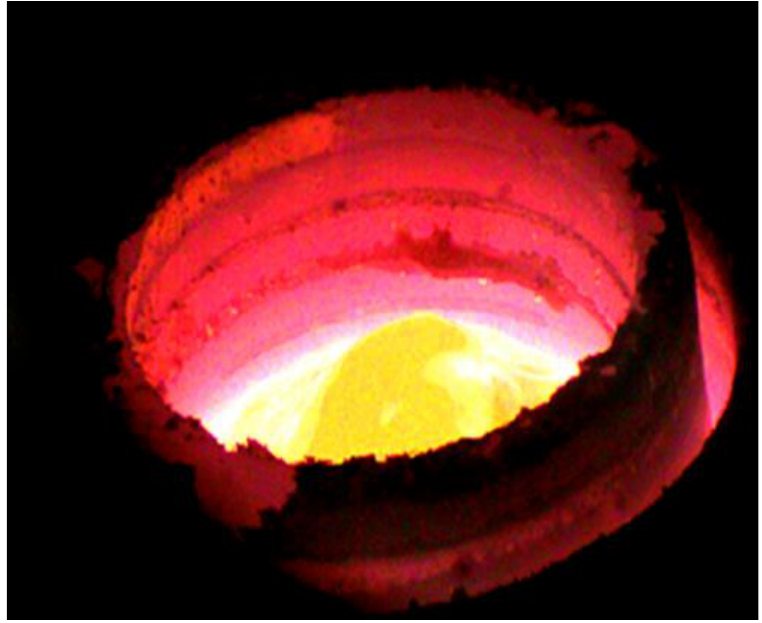
Figure 4. Photo of the surface of molten copper inside an induction furnace. The furnace’s working power is 53 kW [30].